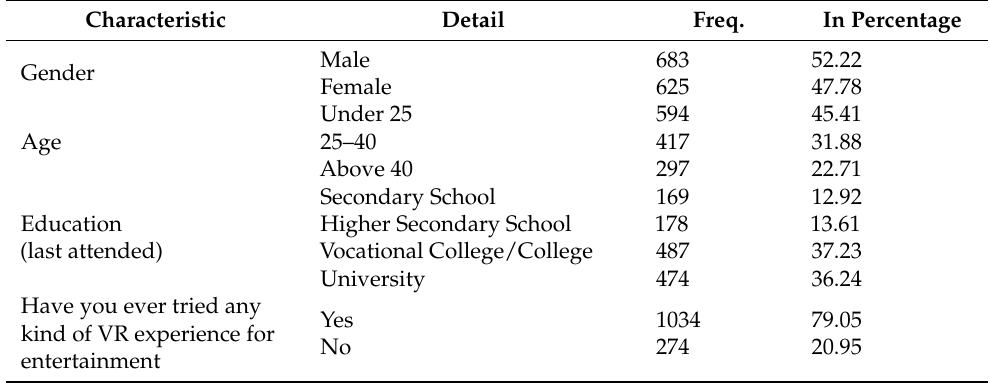
Table 1. Profile of the collected sample.